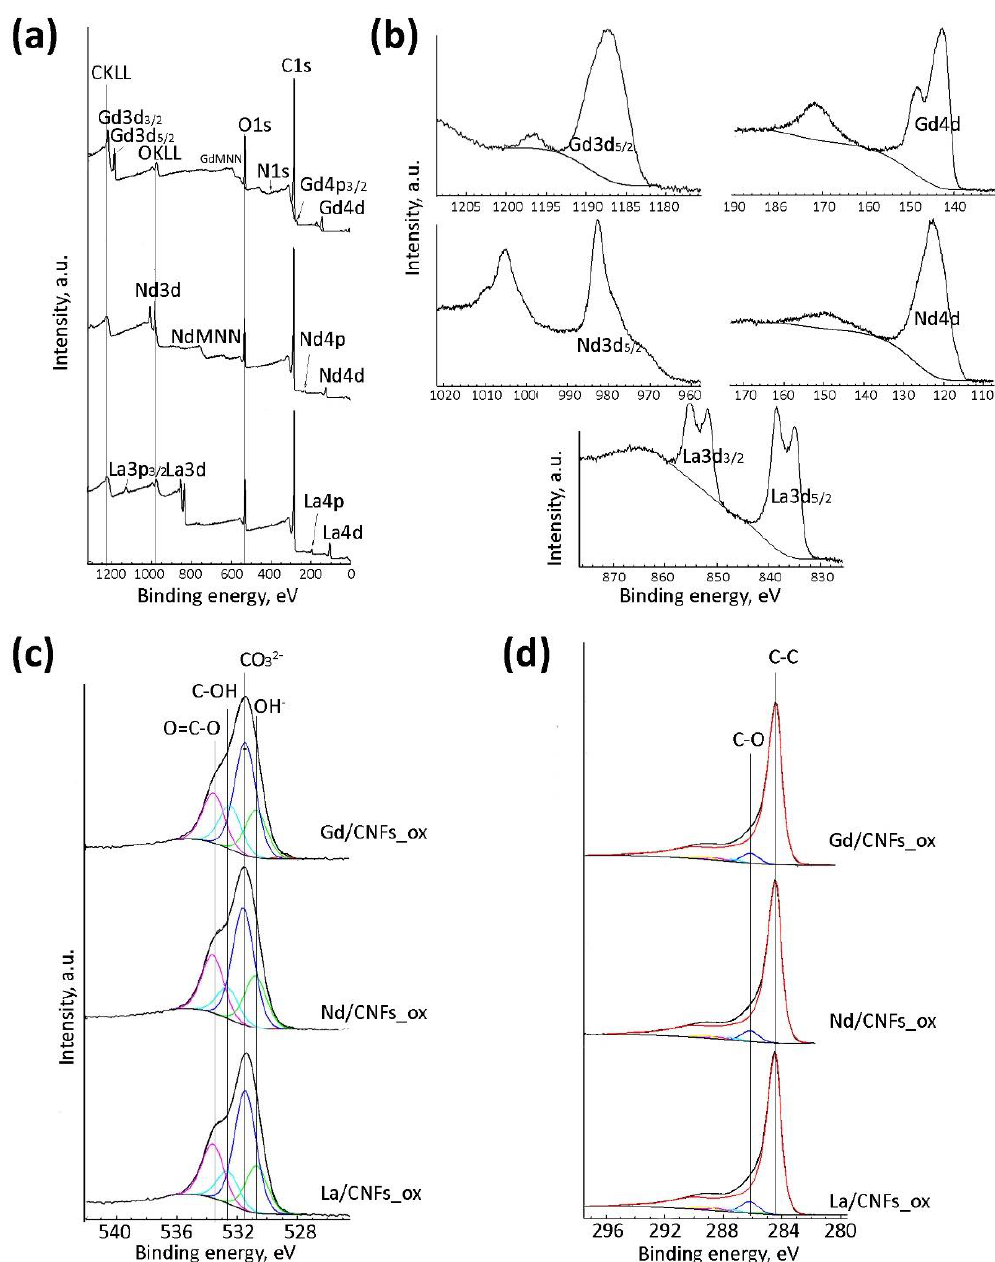
Figure 7. Survey XPS ( a ); La3d, Nd3d, Gd3d ( b ); O1s ( c ) and C1s ( d ) spectra of samples Ln/CNFs_ox.